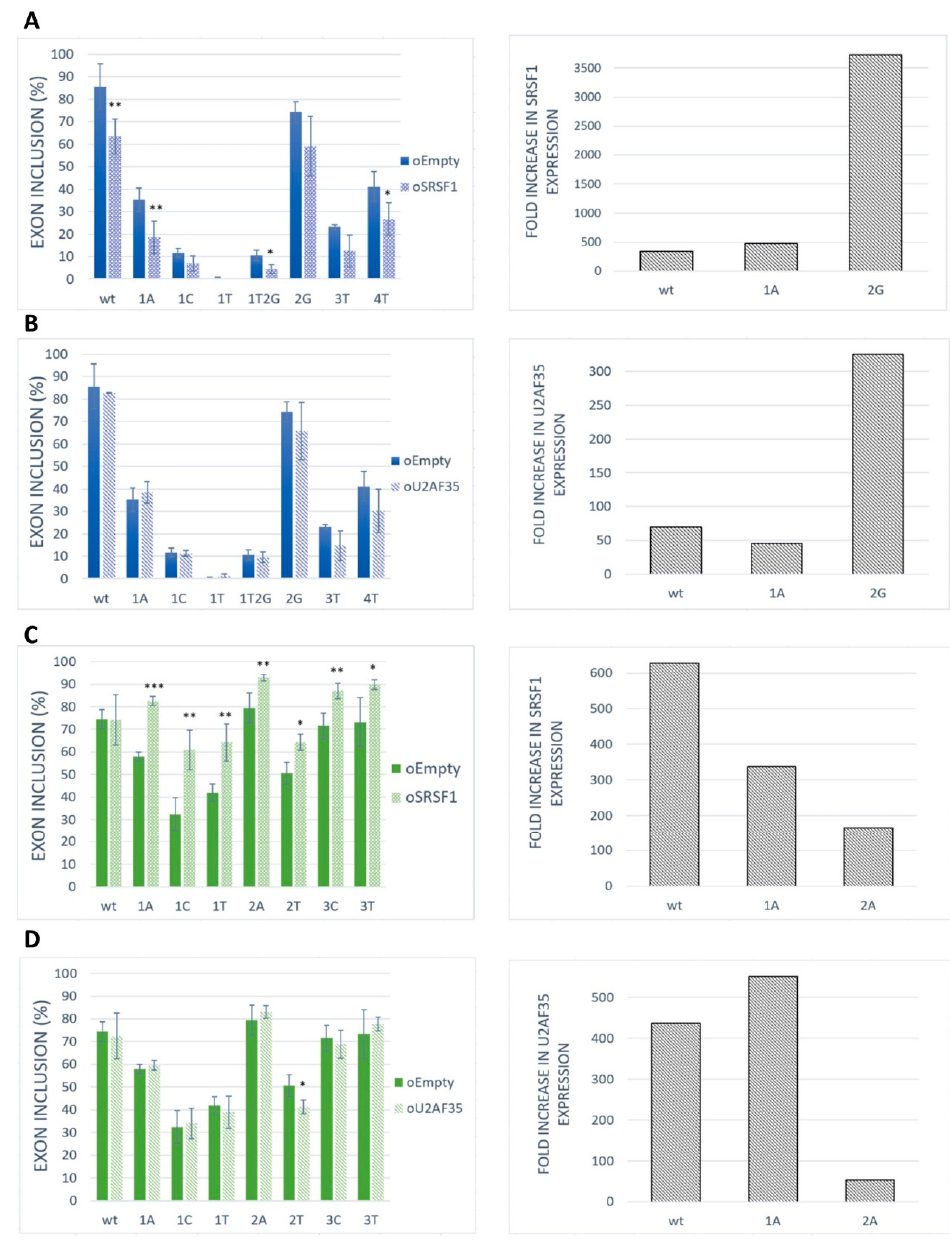
Figure 4. E ff ect of SRSF1 and U2AF35 overexpression on exon recognition. HeLa cells were co-transfected with SRSF1 [39] or U2AF35 [40] expression vectors and BRCA2 or VARS2 minigenes. An empty vector was used as a control. Graphs show proportions of exon inclusion upon SRSF1 overexpression ( A , C ) or U2AF35 overexpression ( B , D ) (light bars) compared to control (dark bars) in BRCA2 exon 12 (blue) ( A , B ) or VARS2 exon 17 (green) ( C , D ). Data are shown as mean exon inclusion percentage ± SD obtained from three independent experiments. Statistically significant di ff erences are shown (* p < 0.05, ** p < 0.01, and *** p < 0.001). On the right, SRSF1 or U2AF35 expression levels are shown as fold-change with respect to control transfections. SRSF1 or U2AF35 expression level upon SRSF1 or U2AF35 overexpression relative to SRSF1 or U2AF35 level from control transfection is